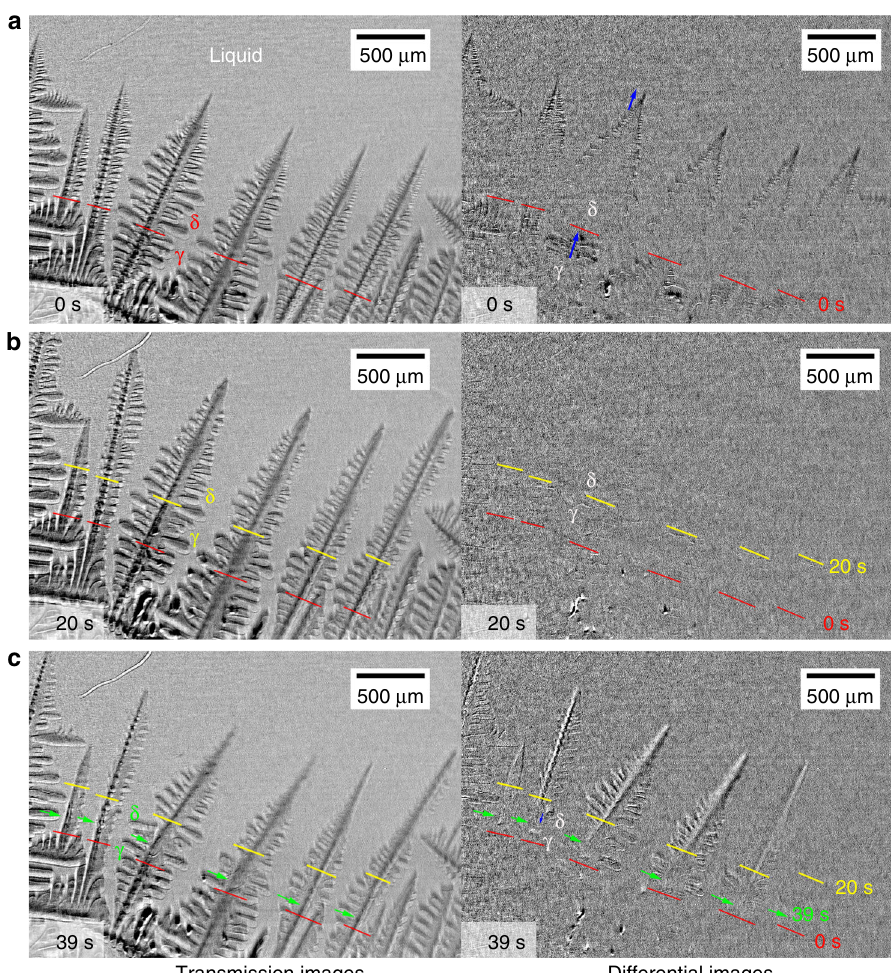
Fig. 2 Multiple fragmentation in the unidirectional solidi fi cation of 0.58C steel. Left and right images are transmission and differential images, respectively. Differential images were obtained by subtracting a transmission image obtained 10 s earlier from a transmission image. a , b δ dendrite arms grew from the bottom to the top. Red and yellow lines indicate the δ – γ interface position at 0 s a and 20 s b , respectively. c Green arrows indicate the δ – γ interface when multiple fragmentation occurred and leaned to the right at 39 s c . Blue arrows approximately indicate growth/melting length in the last 10 s. The X-ray energy and exposure time were 20 keV and 1 s,